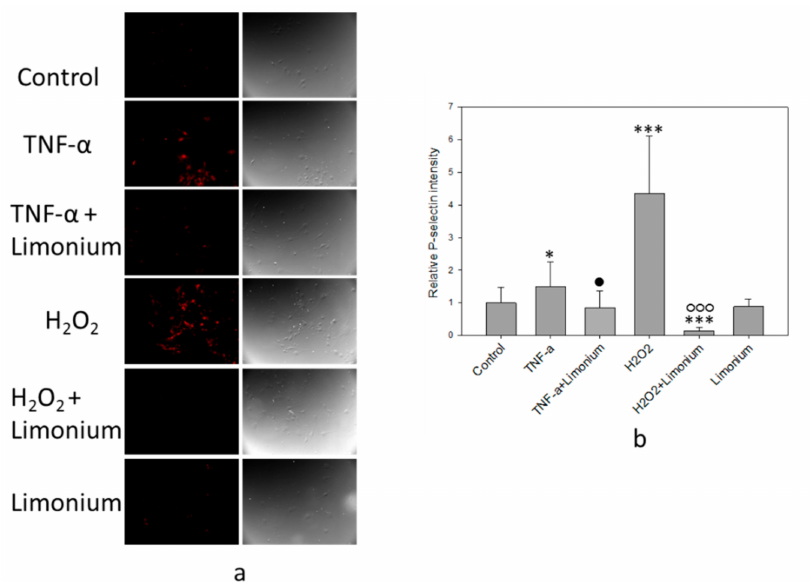
Figure 6. L. gmelinii extract suppresses TNF- α and H 2 O 2 -induced expression of P-selectin on the cell surface. Fluorescent images of P-selectin labeled bEnd3cells ( a ); relative intensity of P-selectin in the bEnd3 ( b ). ***— p ≤ 0.001 compared to the control ; *— p ≤ 0.05 compared to the control ; • — p ≤ 0.05 compared to the cells treated only with TNF- α ; —compared to the cells treated only with H 2 O 2 (cid:35)(cid:35)(cid:35)